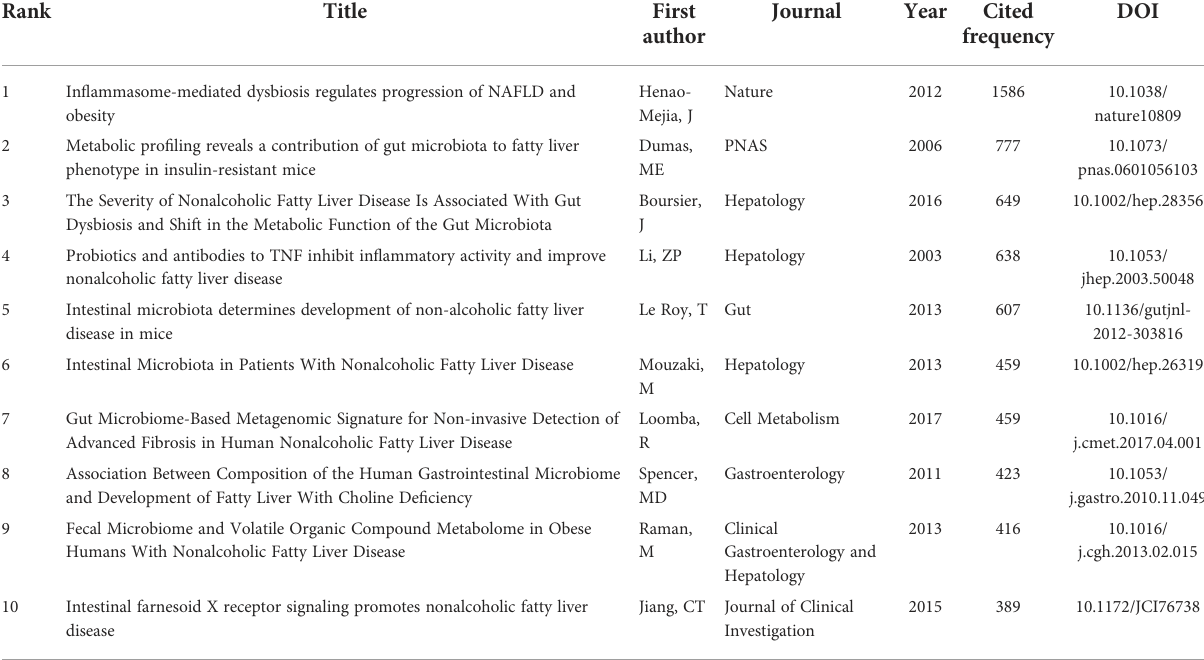
TABLE 2 The top 10 most cited articles from 707 retrieved list in the links of gut microbiota and MAFLD research from 2002 to 2021 (sorted by cited frequency). Rank